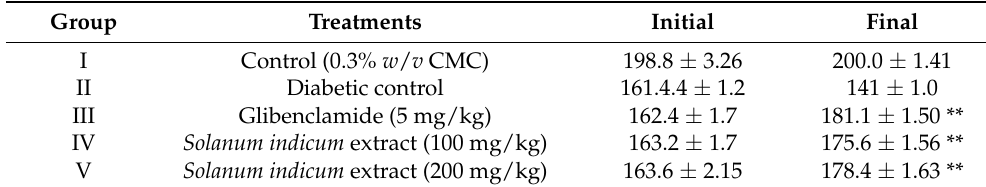
Table 5. Effect of SIE on body weight in STZ induced diabetic rats. Group